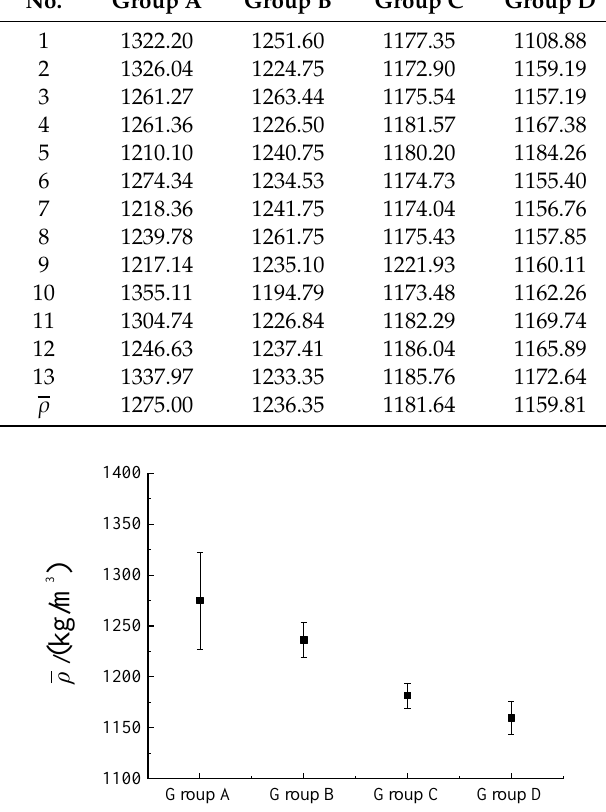
ff erent particle